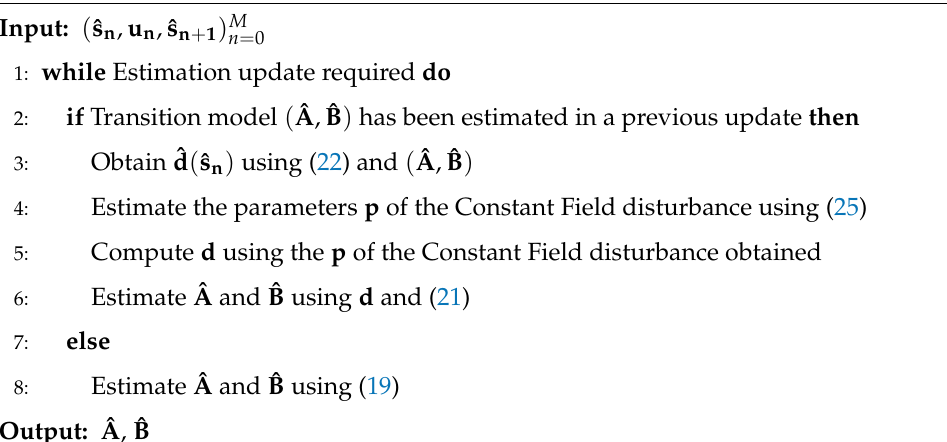
Algorithm 2 Joint transition and Constant Disturbance Estimator